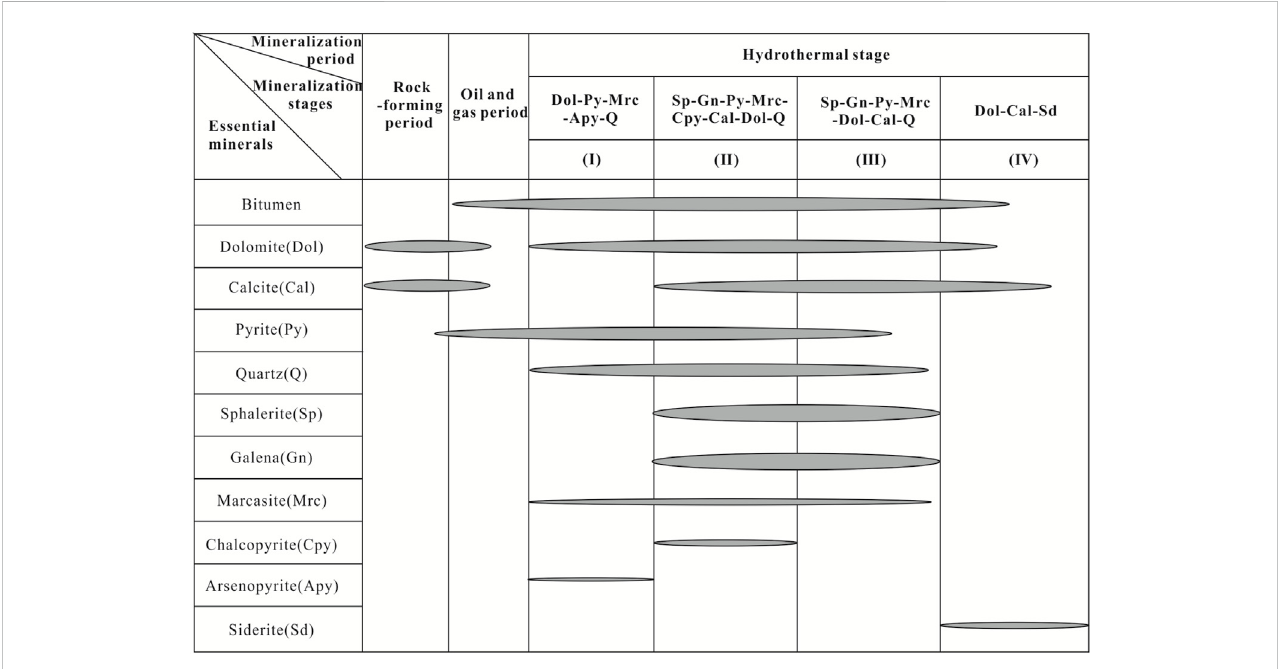
FIGURE 6 The mineralization stages and the mineral arisen sequence in Maoping Pb-Zn